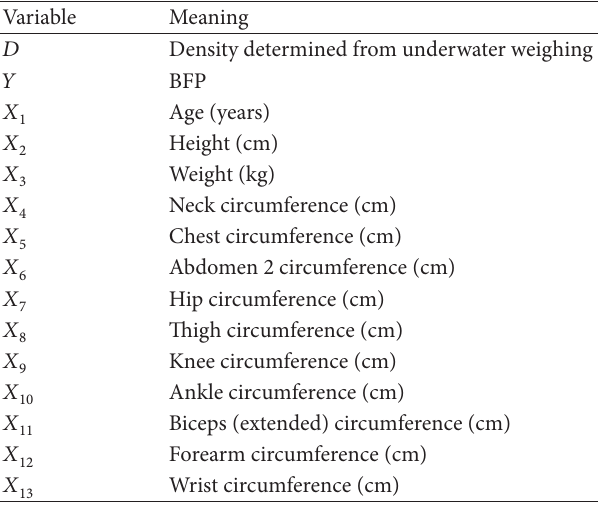
Table 1: Variables’ definition in the BFP